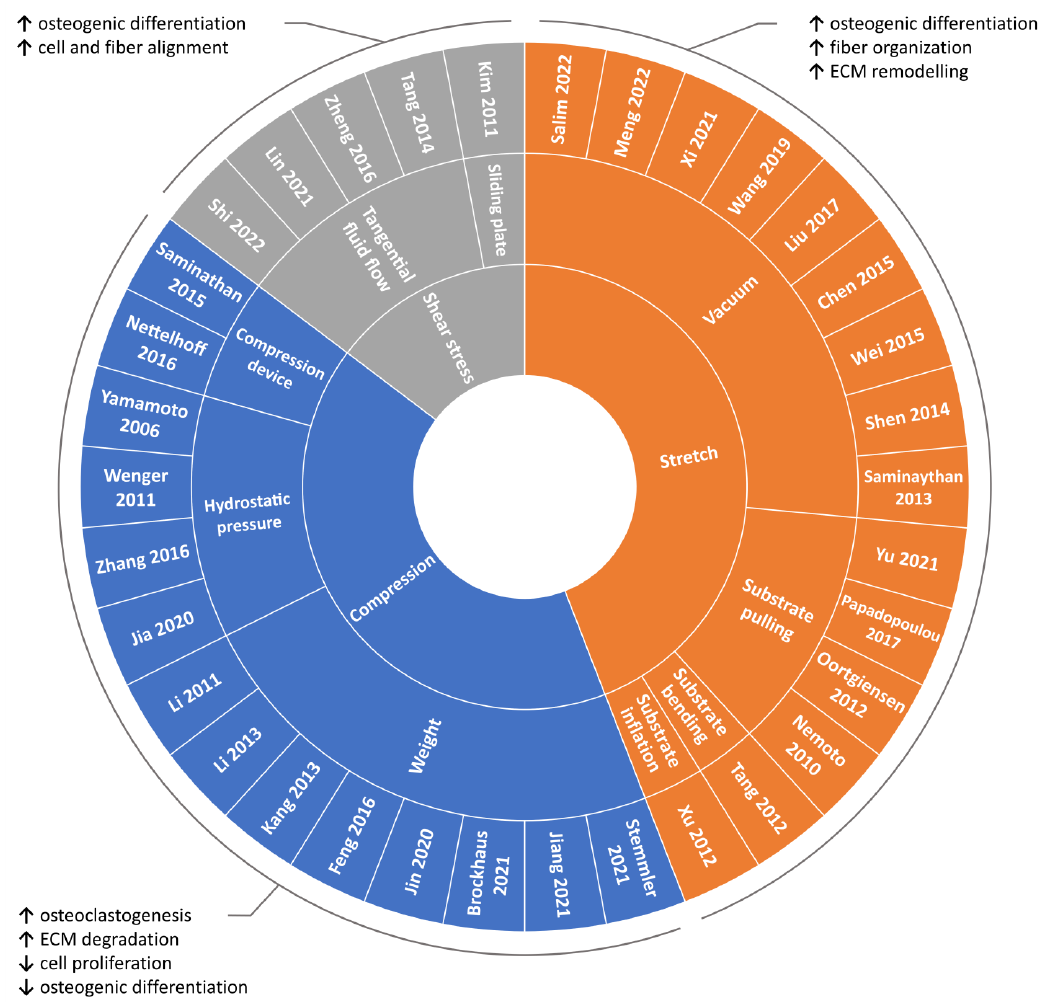
Figure 4. Overview of the reviewed in vitro PDL mechanical loading studies. Schematic summary of the reviewed studies investigating the influence of mechanical loading on PDL cells based on the type of applied stimulation along with main outcomes.